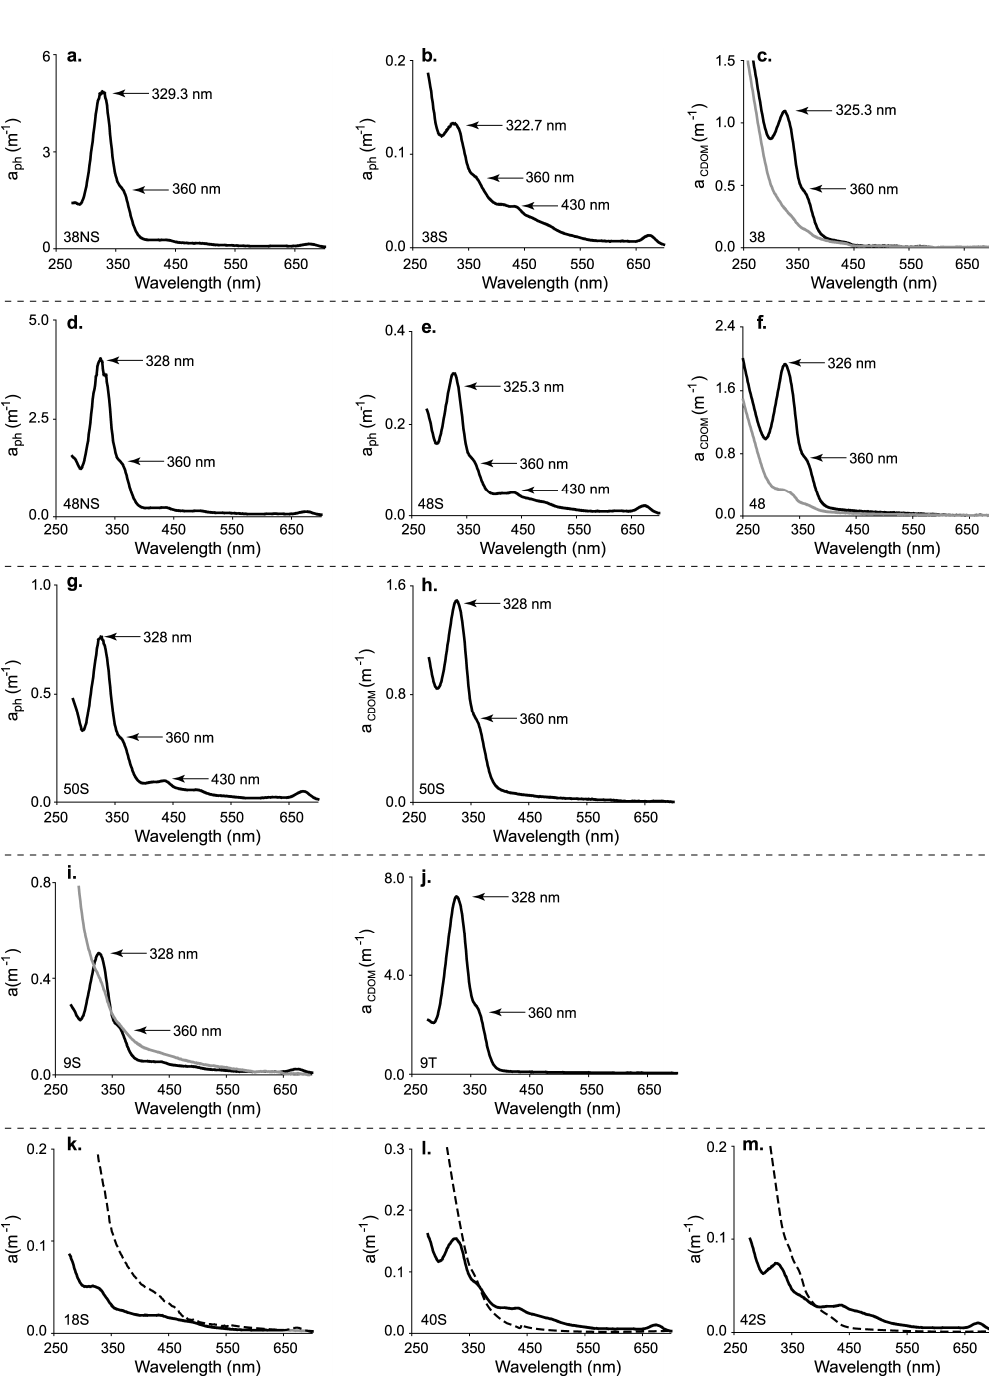
Figure 3. Spectra of the absorption coefficient for the phytoplankton (a ph ) and dissolved (a CDOM ) fractions in samples collected at sites within Keppel Bay. ( a ) a ph for the near-surface layer (NS) sample at site 38; ( b ) a ph for the surface (S) sample at site 38; ( c ) a CDOM for the surface sample (grey line) and the near-surface layer sample (black line) at site 38; ( d ) a ph for the near-surface layer (NS) sample at site 48; ( e ) a ph for the surface (S) sample at site 48; ( f ) a CDOM for the surface sample (grey line) and the near-surface. layer sample (black line) at site 48; ( g ) a ph for the surface (S) sample at site 50; ( h ) a CDOM for the surface sample at site 50; ( i ) a ph (black line) and a CDOM (dotted grey line) of the surface sample at site 9; ( j ) a CDOM for the water sample from the outflow of the ac-9 (T) at site 9; ( k ) a ph (black line) and a CDOM (dotted line) of the surface sample at site 18; ( l ) a ph (black line) and a CDOM (dotted line) of the surface sample at site 40; ( m ) a ph (black line) and a CDOM (dotted line) of the surface sample at site